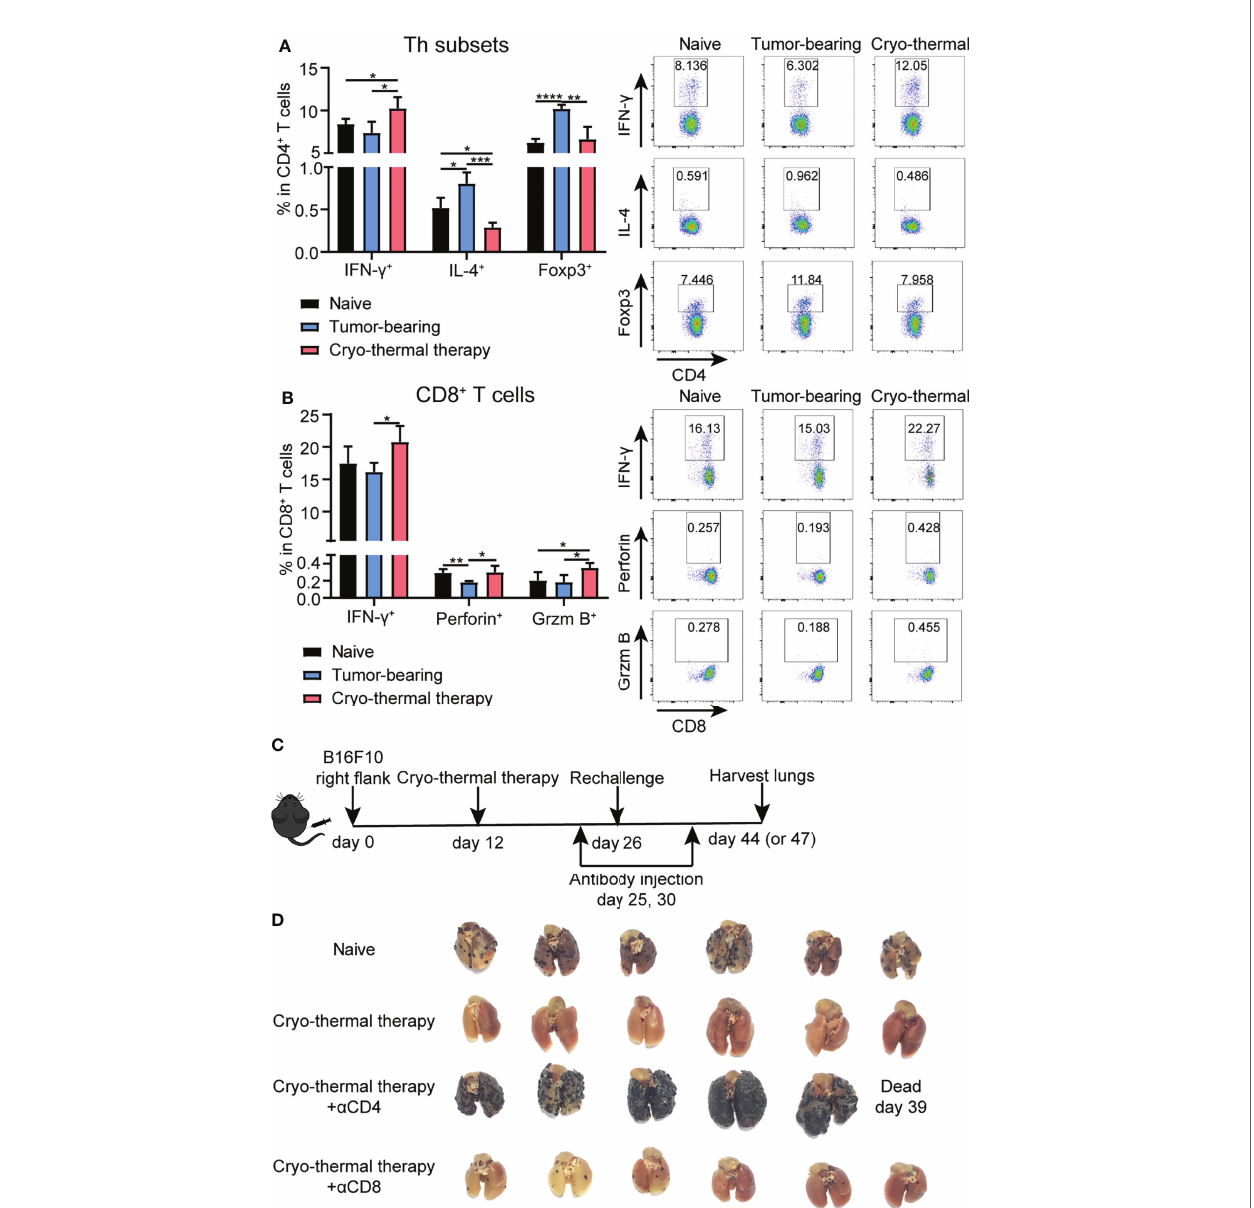
FIGURE 1 | Phenotype of T cells after cryo-thermal therapy and tumor growth in rechallenge model depleted of T cells in vivo . Splenocytes of naïve, tumor bearing and cryo-thermal treated mice on day 14 after therapy were obtained to detect the phenotype of (A) CD4 + T cells; (B) CD8 + T cells by using fl ow cytometry. All data were shown as mean±SD. n =4 for each group. *P < 0.05, **P < 0.01, ***P < 0.001, ****P < 0.0001. Data for graphs were calculated by using two-sided Student ’ s T-test. (C) Scheme of tumor rechallenge model. Approximately 5 × 10 5 B16F10 cells were injected subcutaneously into the right fl ank of each mouse. Twelve days later, mice were treated with cryo-thermal therapy. Tumor rechallenge was conducted 14 days later, with 1 × 10 5 B16F10 cells injected via tail vein. One day before and four days after tumor rechallenge, monoclonal antibodies were injected to deplete target cells or neutralize target cytokine. All mice were sacri fi ced on day 44 or 47 to detect tumor nodules in the lung and immune cells in the spleen. (D) Picture of tumor nodules in the lung after tumor rechallenge depleted of CD4 + T cells or CD8 + T cells. n =6 per